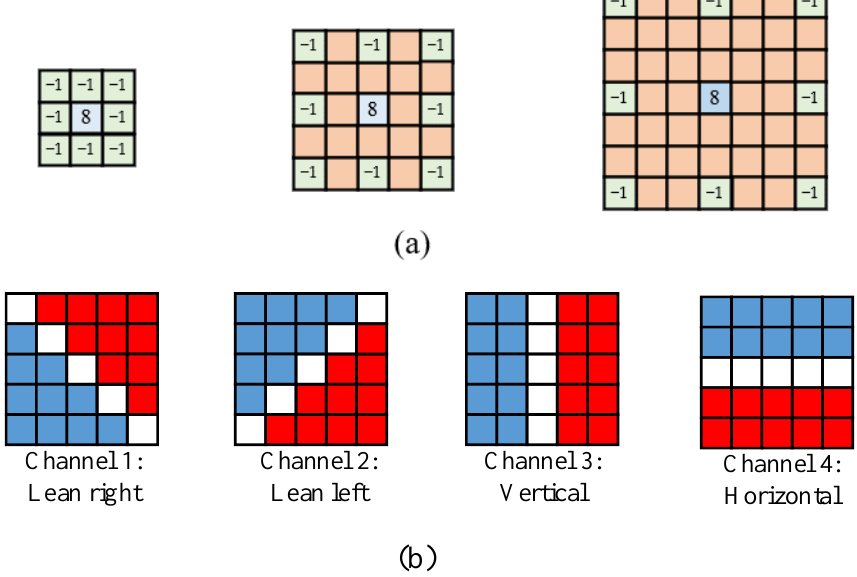
Figure 3. ( a ) Directional gradient calculation diagram; ( b ) four regional gradient channels.